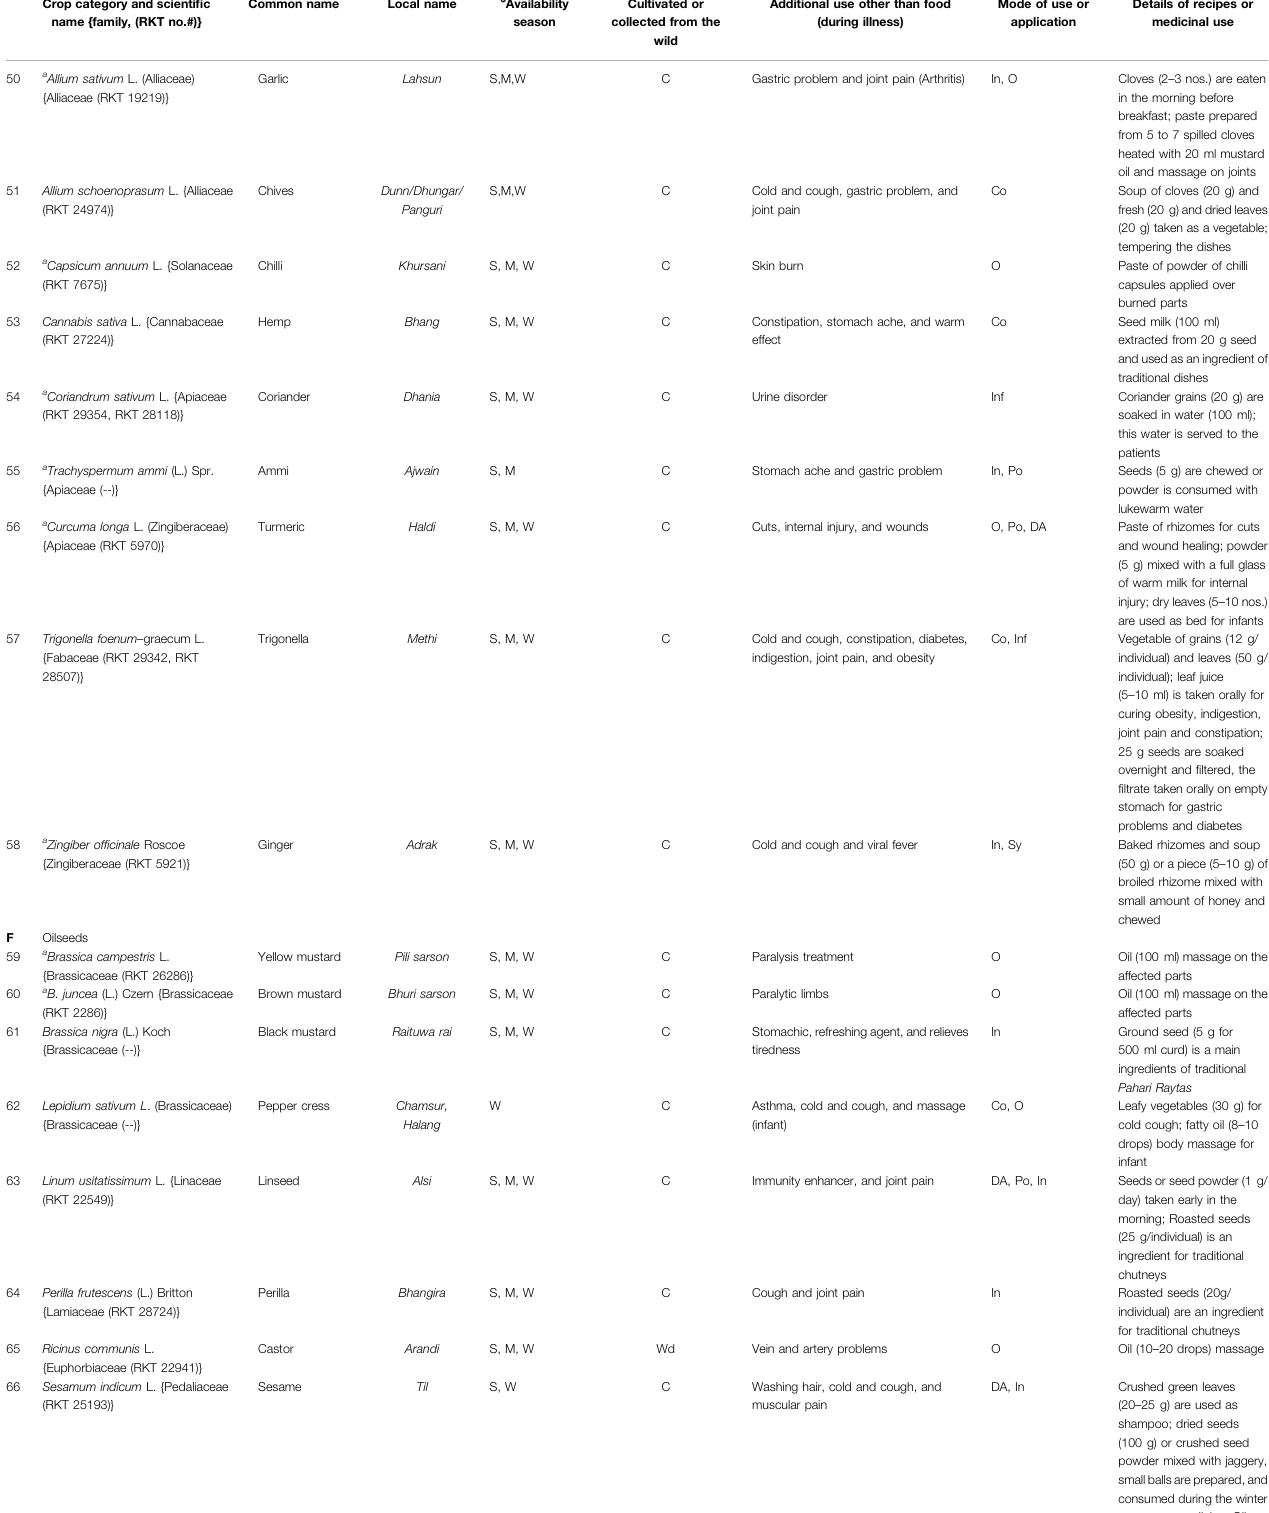
season as medicine, Oil used in